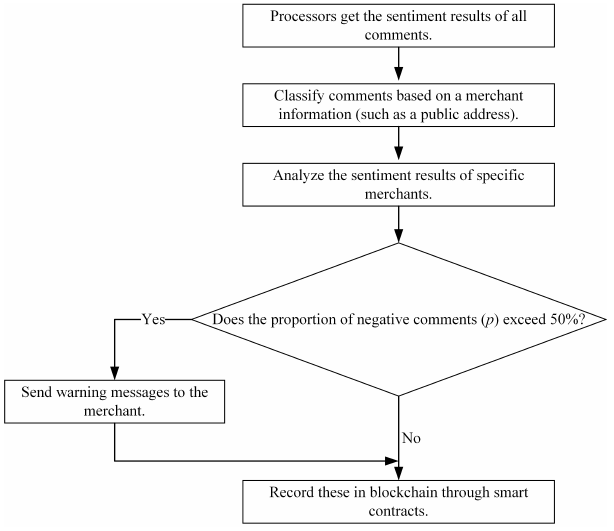
Figure 4. The process of sending warning messages to problematic merchants.